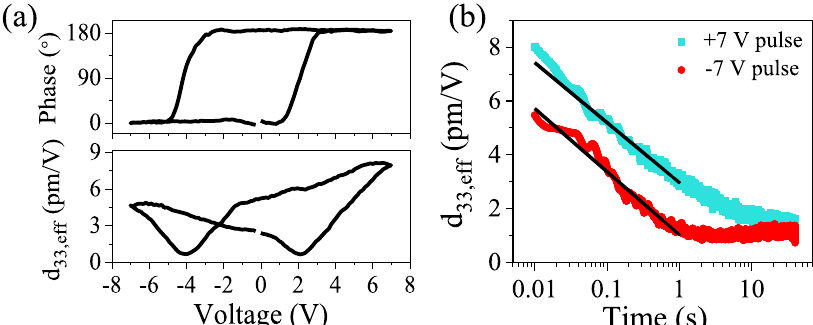
Fig. 5 Voltage and time dependence of local piezo response. a Bias-off PFM amplitude (bottom panel) and phase (top panel) hysteresis loops measured in the Pt/B:Cr 2 O 3 (200 nm)/V 2 O 3 structure. b PFM amplitude signal as a function of time elapsed after application of a positive (blue) and negative (red) poling pulses (7 V, 12.5 ms). Solid lines in b illustrate the logarithmic fi t of the temporal decay of the effective piezoelectric coef fi cient d 33 ( t ) in accordance with a relaxation model for electric fi eld-oriented